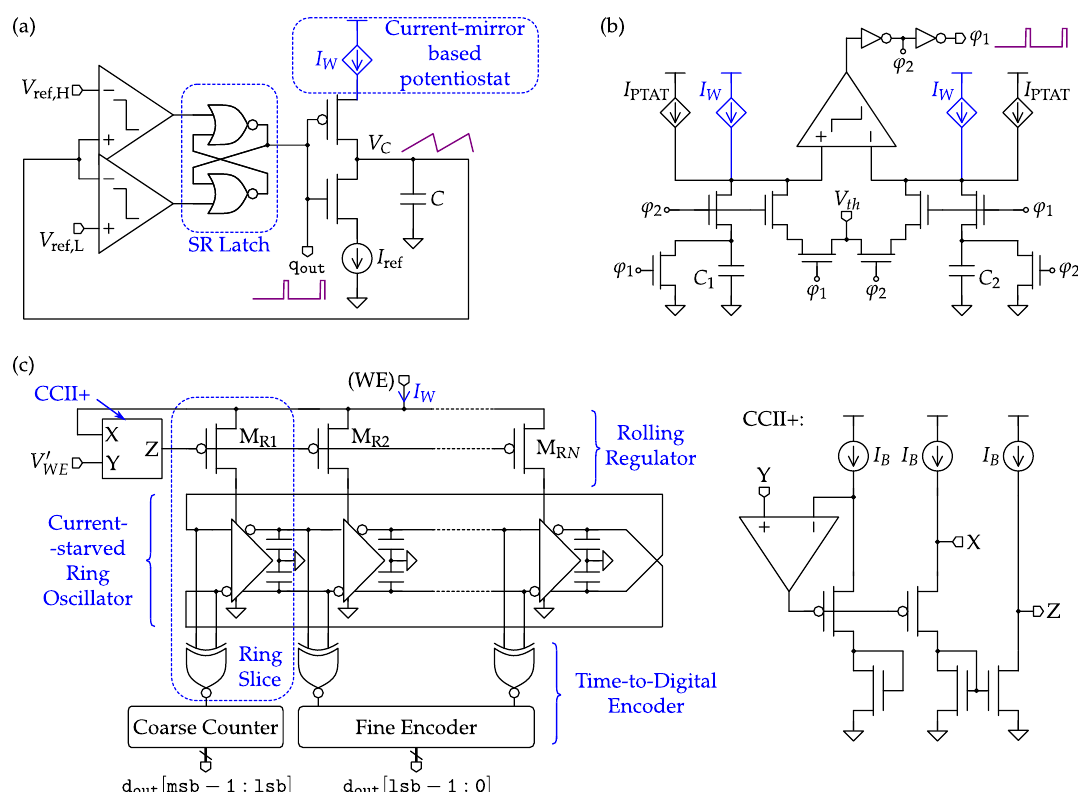
Figure 16. Potentiostats with embedded current to frequency conversion (I-to-f type): ( a ) based on conventional relaxation oscillator; ( b ) based on single-comparator relaxation oscillator; ( c ) based on current-starved ring